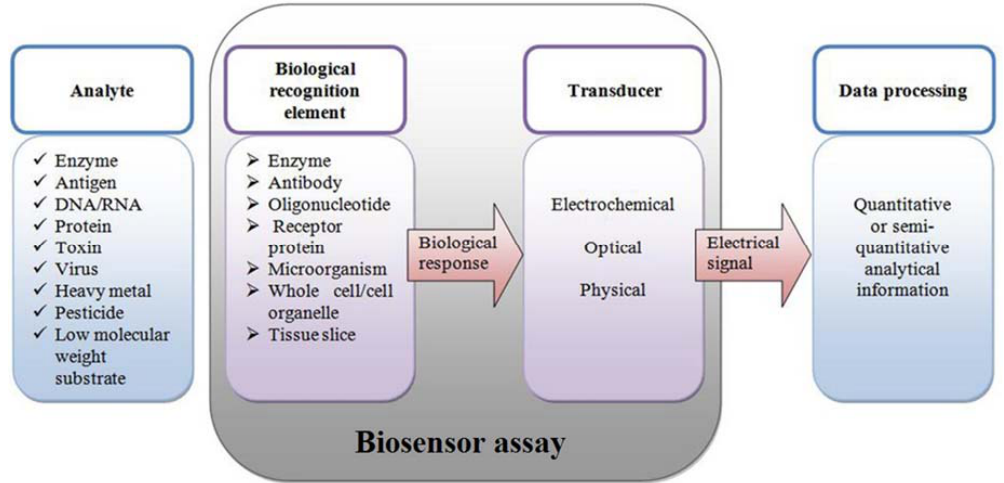
Figure 3. Principle of biosensor operation and main components: the analyte is detected by the biologically-affined sensitive layer, immobilized on the transducer. The biological response is transformed to an electrical, optical or electrochemical signal by the transducer and then further processed, providing the information. Data are summarized from [20,21].